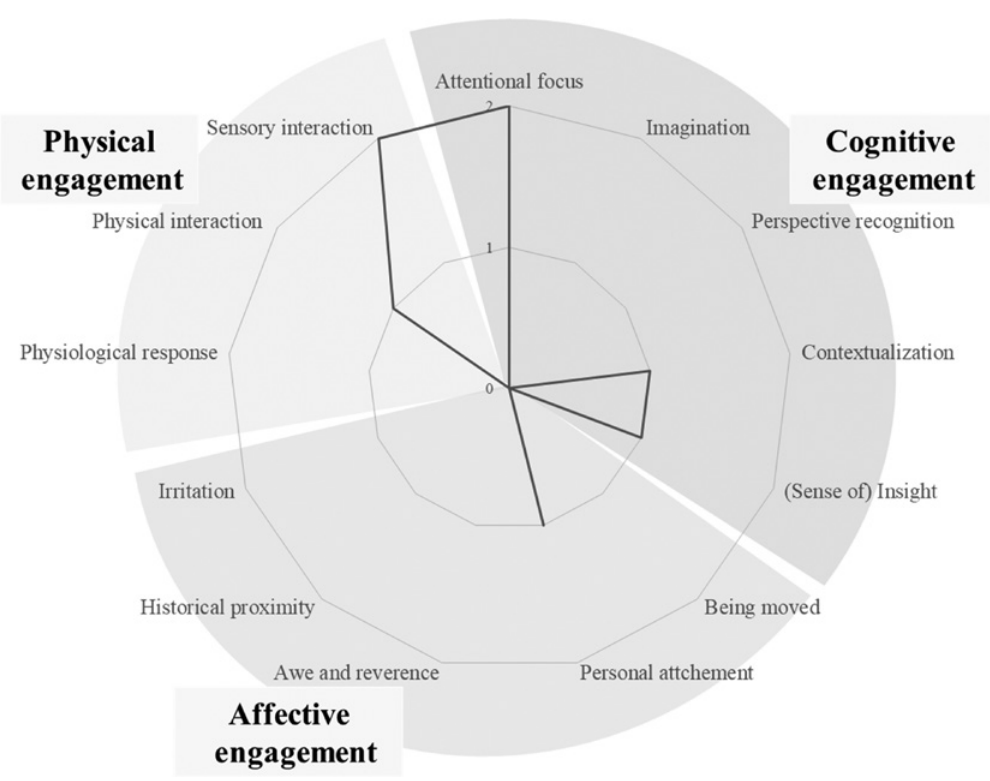
Figure 3: Coding frequency for each response for the student interview about the eyewitness